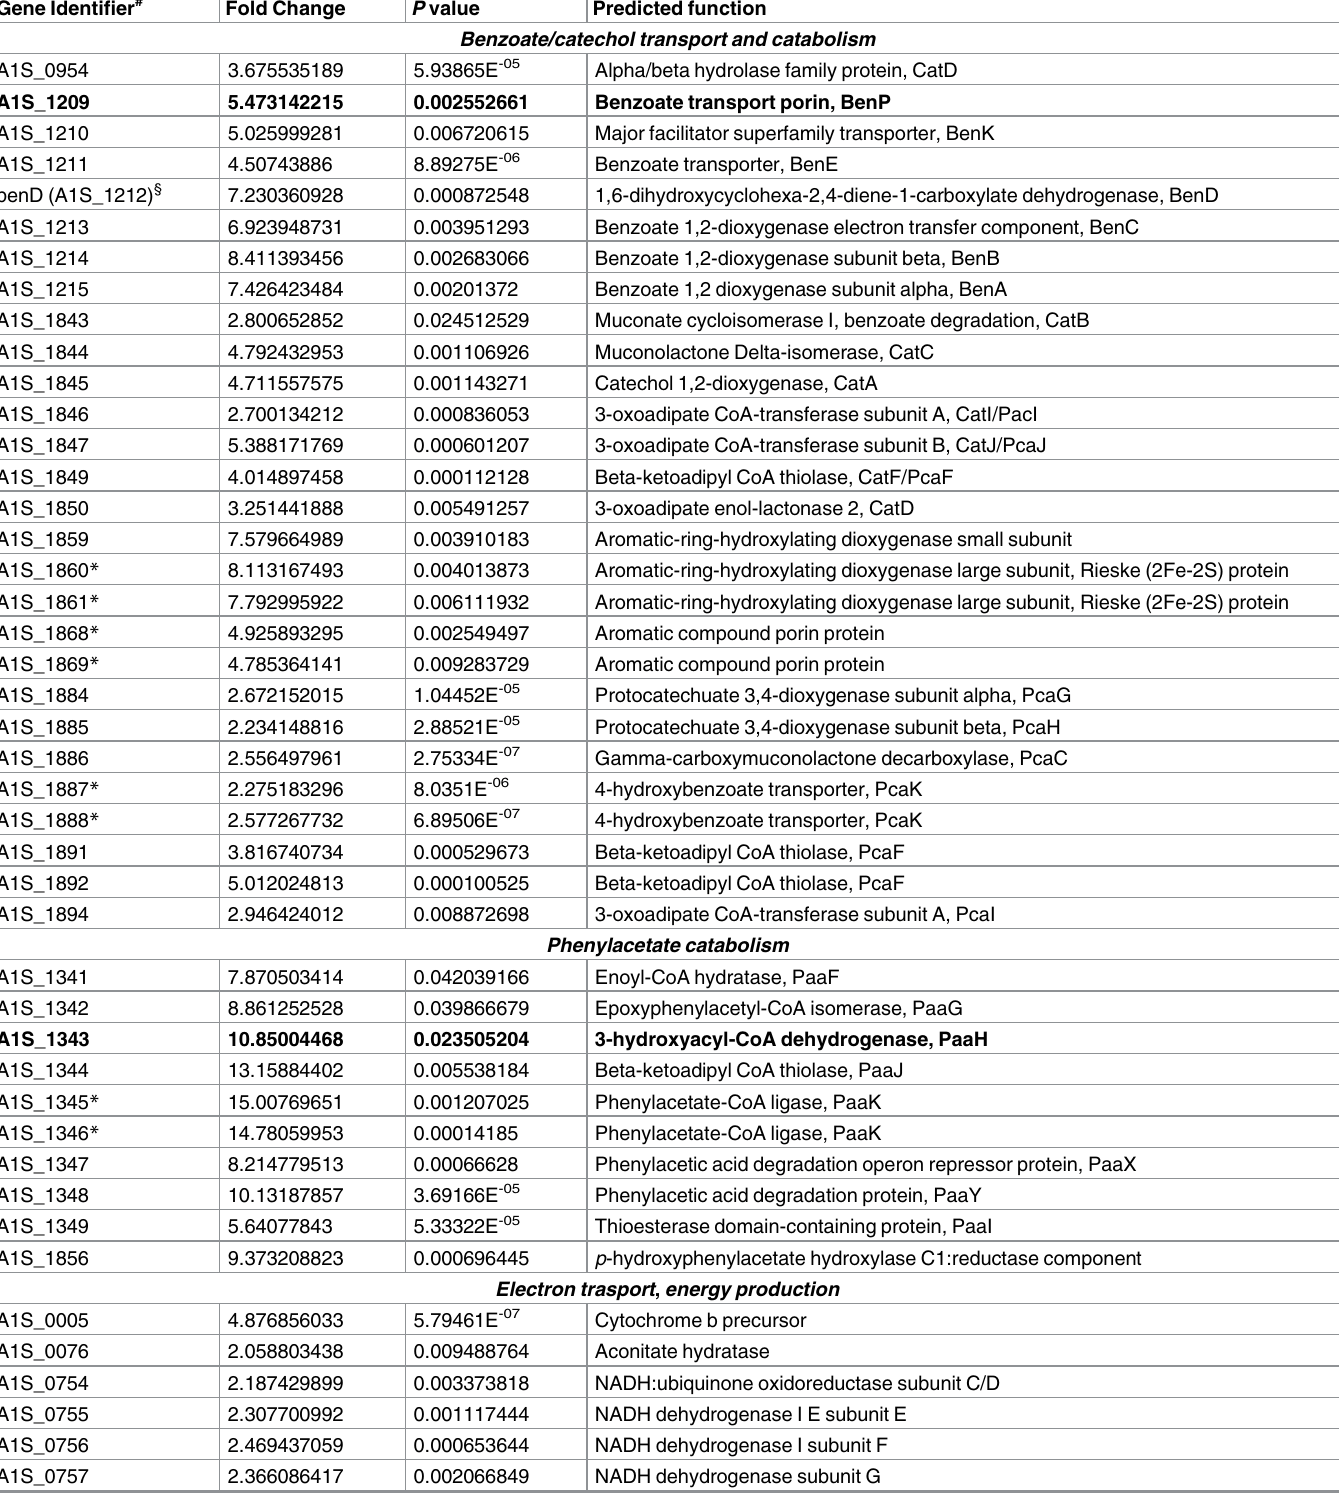
Table 1. A . baumannii ATCC 19606 T metabolic genes with increased expression in the presenceof mucin. Gene Identifier